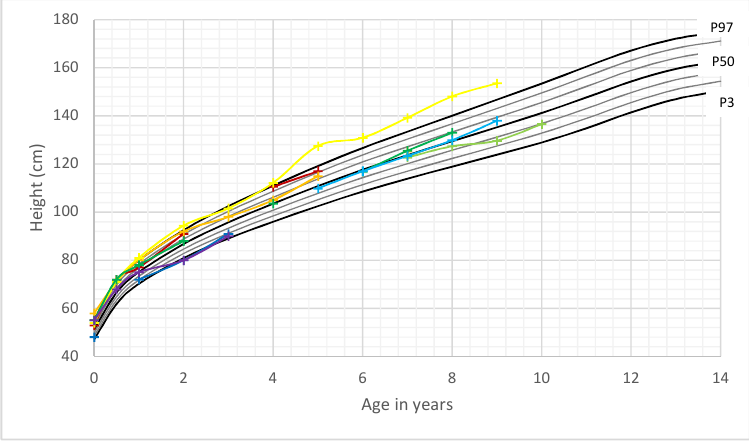
Figure 4. Height of female PHTS patients in comparison to German reference growth charts [11]. Legend: ___: P3 – P97. Colored lines: individual patient’s length curves.